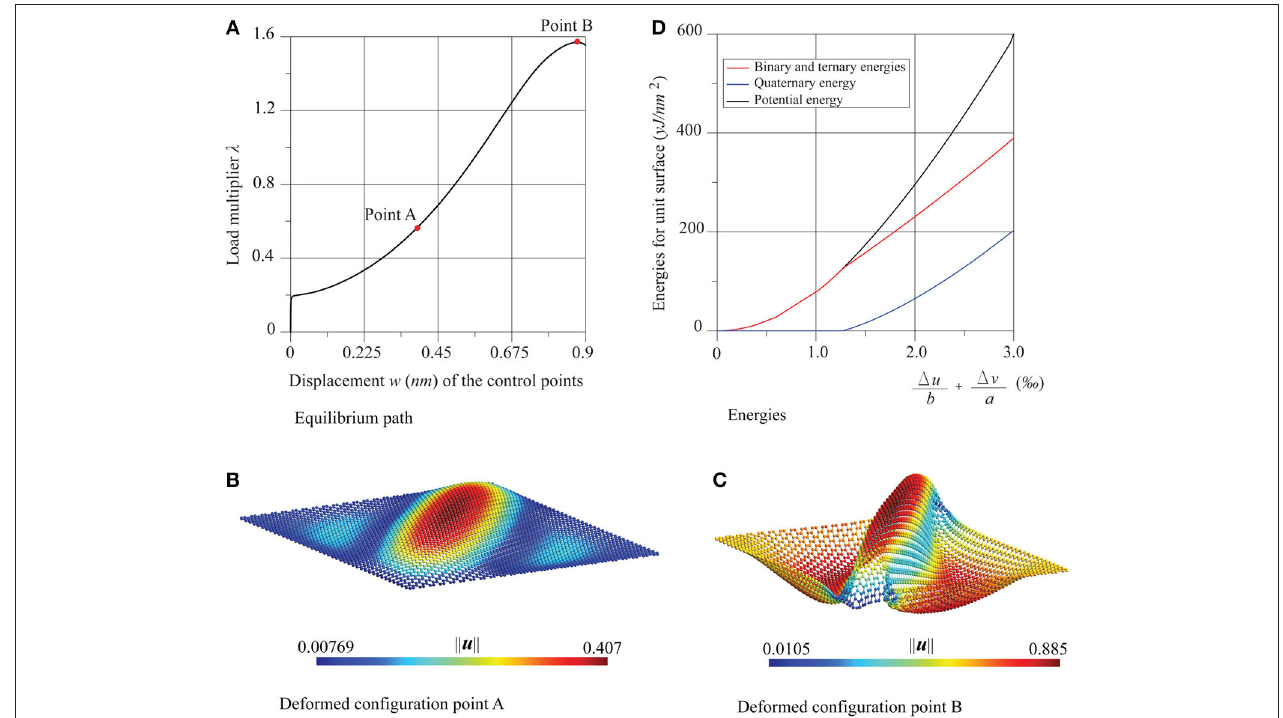
FIGURE 7 | Graphene sheet under shear: (A) equilibrium path, (B,C) deformed configurations at the points A and B , and (D) energies trends.